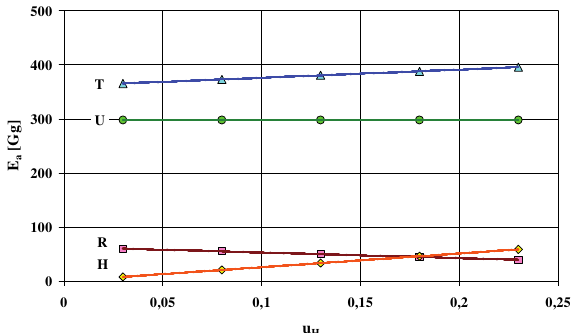
Fig. 8. Dependence of the national annual emission of carbon monoxide from passenger cars upon the road length travelled under the following model traffic conditions: U – urban, R – rural, H – on highways and expressways as well as T – under all conditions